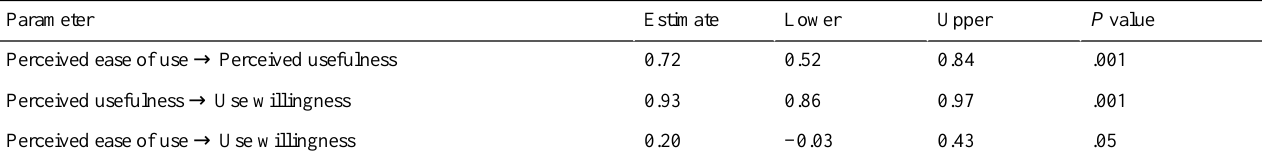
Table 4. Trust interval and discriminant validity of the correlation